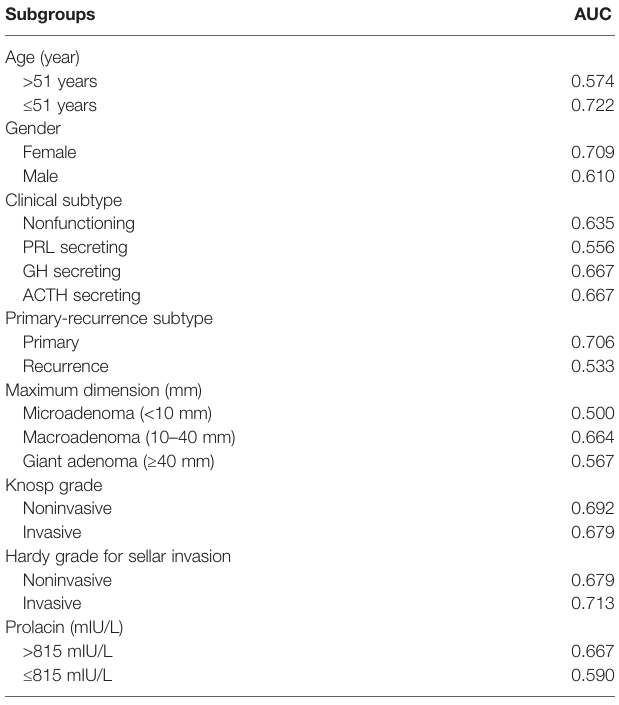
TABLE 3 | ROC analysis in subgroups. Subgroups